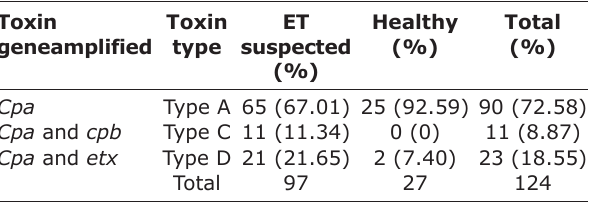
Table 3: Toxin genotyping of C. perfringens isolates by multiplex PCR. Toxin Toxin geneamplified